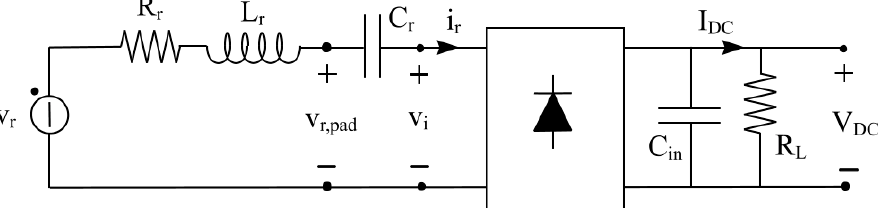
Figure 9. Electrical scheme of the IPT kit: equivalent circuits of the pads and of the compensating networks (LCL type on transmitter and LC series on receiver) are considered. The battery pack is modeled as a series connection between a resistance R bat and a constant voltage source V bat .